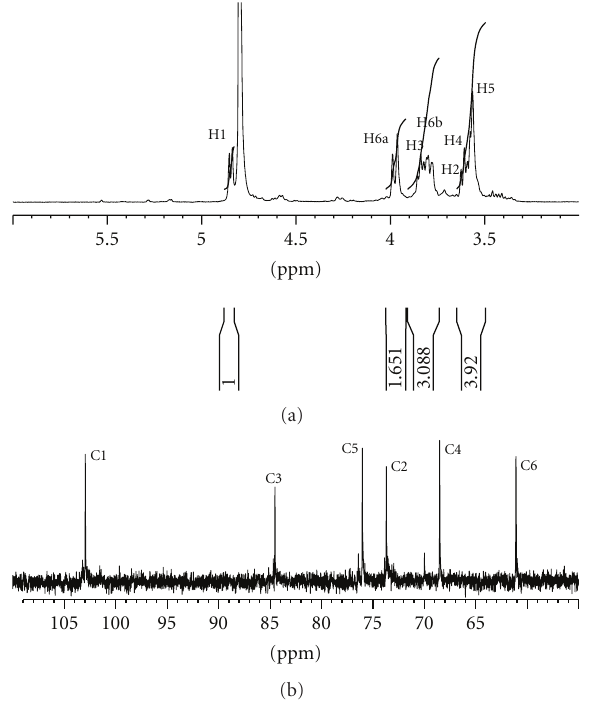
Figure 2: The 1 H NMR spectrum (a) and 13 C NMR spectrum (b) of LMG. These signals were in agreement with those of β -1,3-glucan from previously results [11].